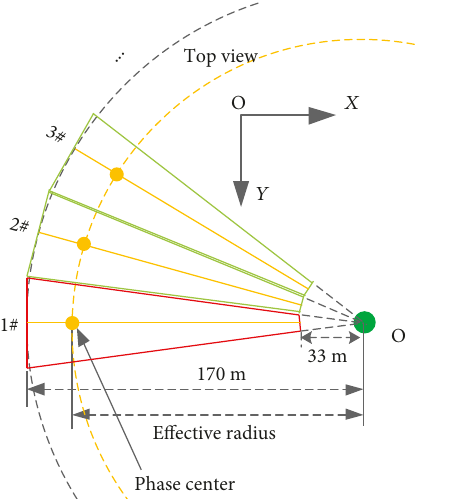
Figure 3: The limited area (red color-marked region) of the LPDA in the circular array.